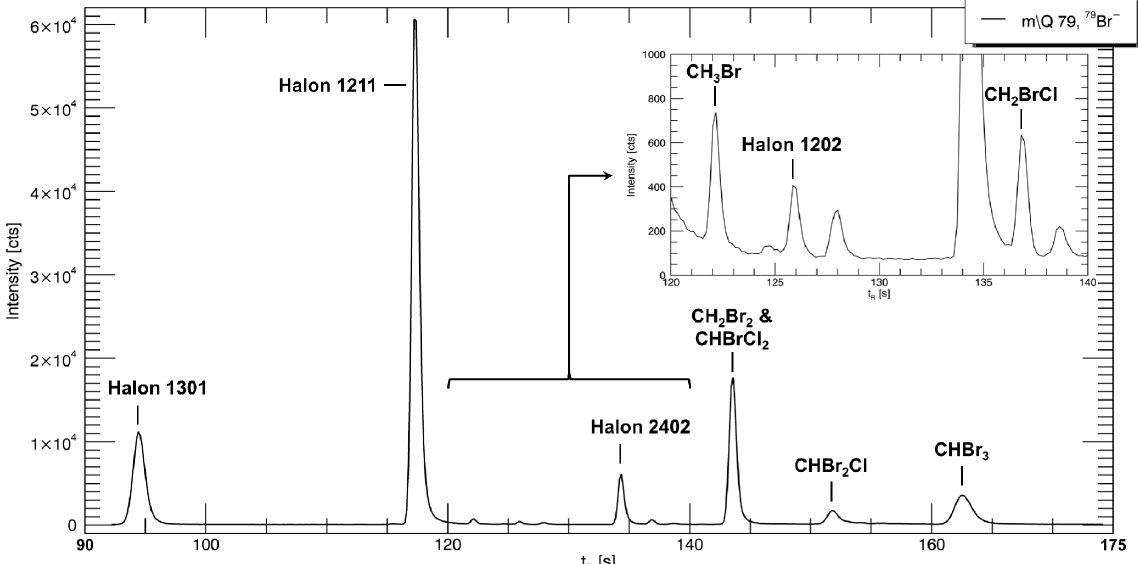
Figure 7. Chromatogram from a preconcentration of 0.1L ambient air obtained with the in situ GC–MS set-up GhOST-MS. X axis: retention time t R in seconds. Y axis: signal intensity in counts, arbitrary unit. MS: Agilent 5975C in negative chemical ionisation mode (reagent: argon). Black graph: mass-to-charge ratio m/Q = 79 signal of 79 Br − ions from brominated trace gases.